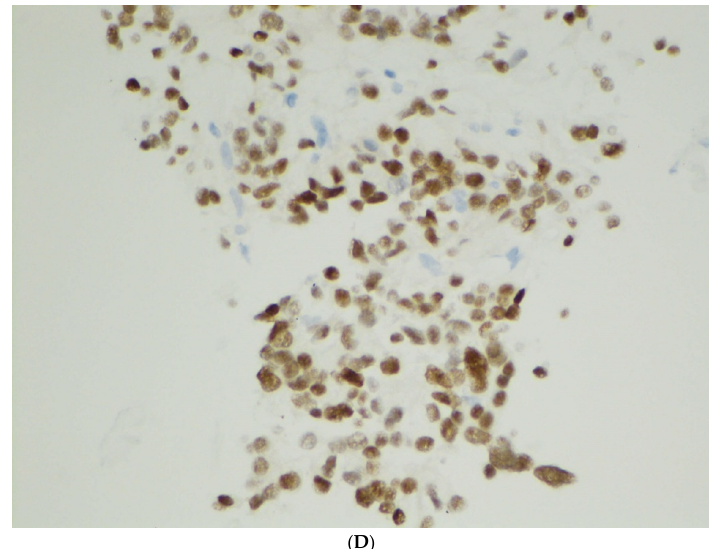
Figure 3. ( A ) Weak immunostaining for synaptophysin (Case #14, cell block, original magnification ×400). ( B ) Strong nuclear and cytoplasmic immunostaining for β -catenin (Case #14, cell block, original magnification ×400). ( C ) Nuclear immunostaining for cyclin-D1 (Case #14, cell block, original magnification ×400). ( D ) Nuclear immunostaining for progesterone receptor (Case #14, cell block, original magnification ×400).